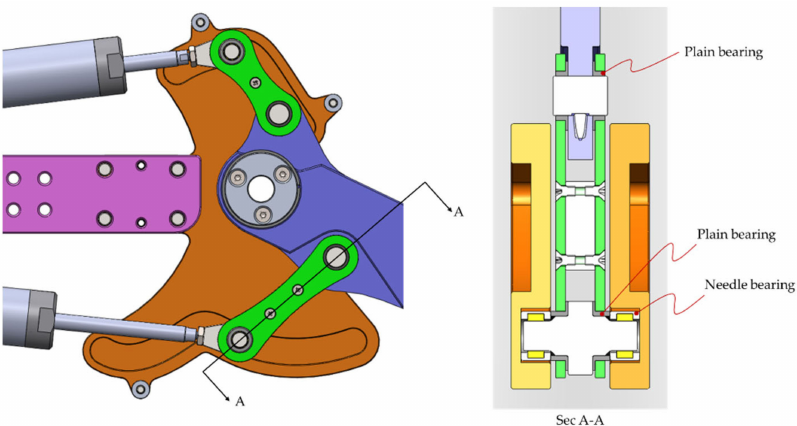
Figure 21. Illustration of the bearings (plain bearings from Igus and needle bearings) used in the design.